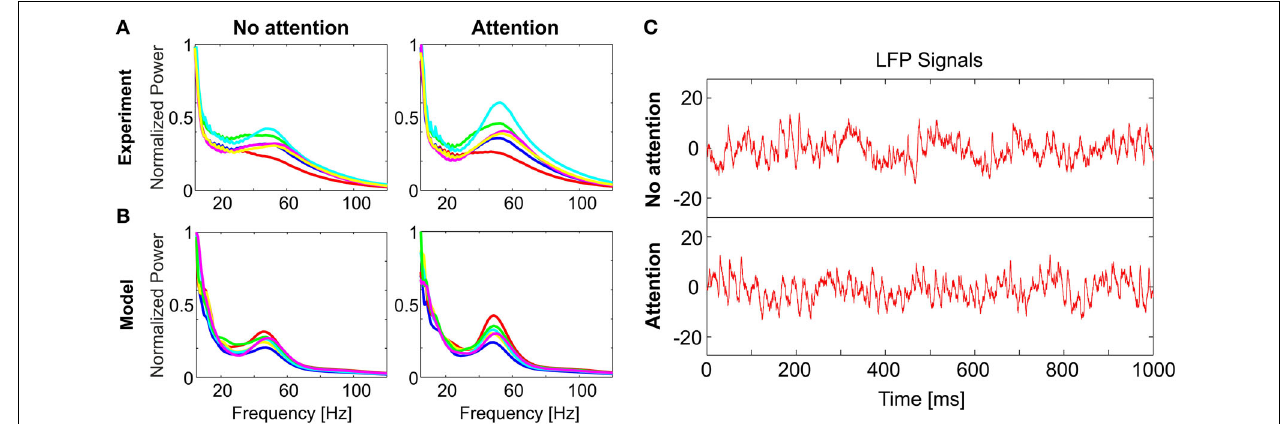
FIGURE 2 | Comparison of model dynamics to experimental recordings. LFP spectral power distributions in (A) the experiment and (B) the model for non-attended (left) and attended (right) conditions. In each case, spectra averaged over trials is shown for 6 stimuli (different colors). In both (A,B) the spectra for each stimulus is normalized to its respective maximum in the non-attended case. Model spectra reproduce the stereotypical 1 / f background